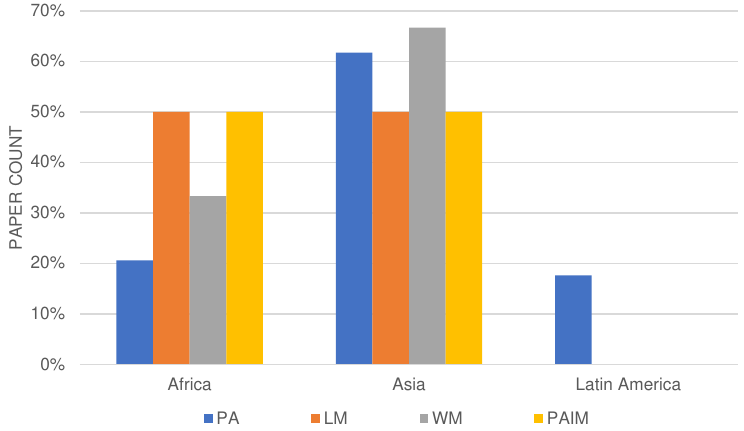
Figure 11. Spatial distribution to continent of IoT and WSN applications in smallholder agriculture (PA:Precision Agriculture, LM: Livestock Management, WM: Weather Monitoring, PAIM: Pest and Animal Infestation Monitoring). The Y-axis denotes percentage distribution of works in the three continents and over each application domain.